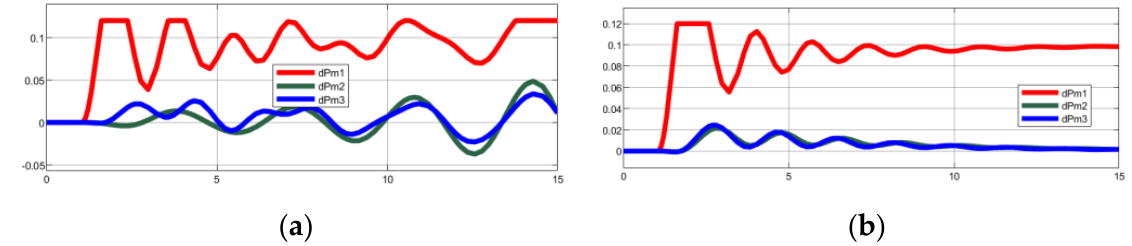
Figure 14. ( a ) Mechanical Power Deviations, Case 3. ( b ) Mechanical Power Deviations, Case 4.